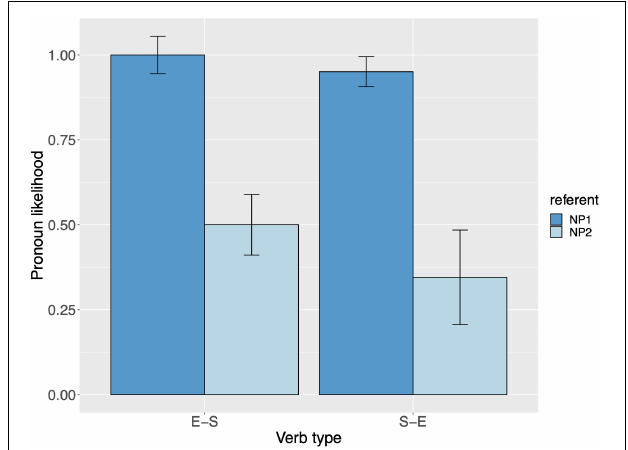
FIGURE 6 | Personal pronoun: probability of using a personal pronoun to refer to NP1 and NP2, per verb type, for Experiment 2. These bars represent the pronoun production likelihoods (and are therefore based on the free-prompt data). Error bars are by-participant and represent 95% confidence intervals based on normalized data (Morey, 2008; Chang, 2013).